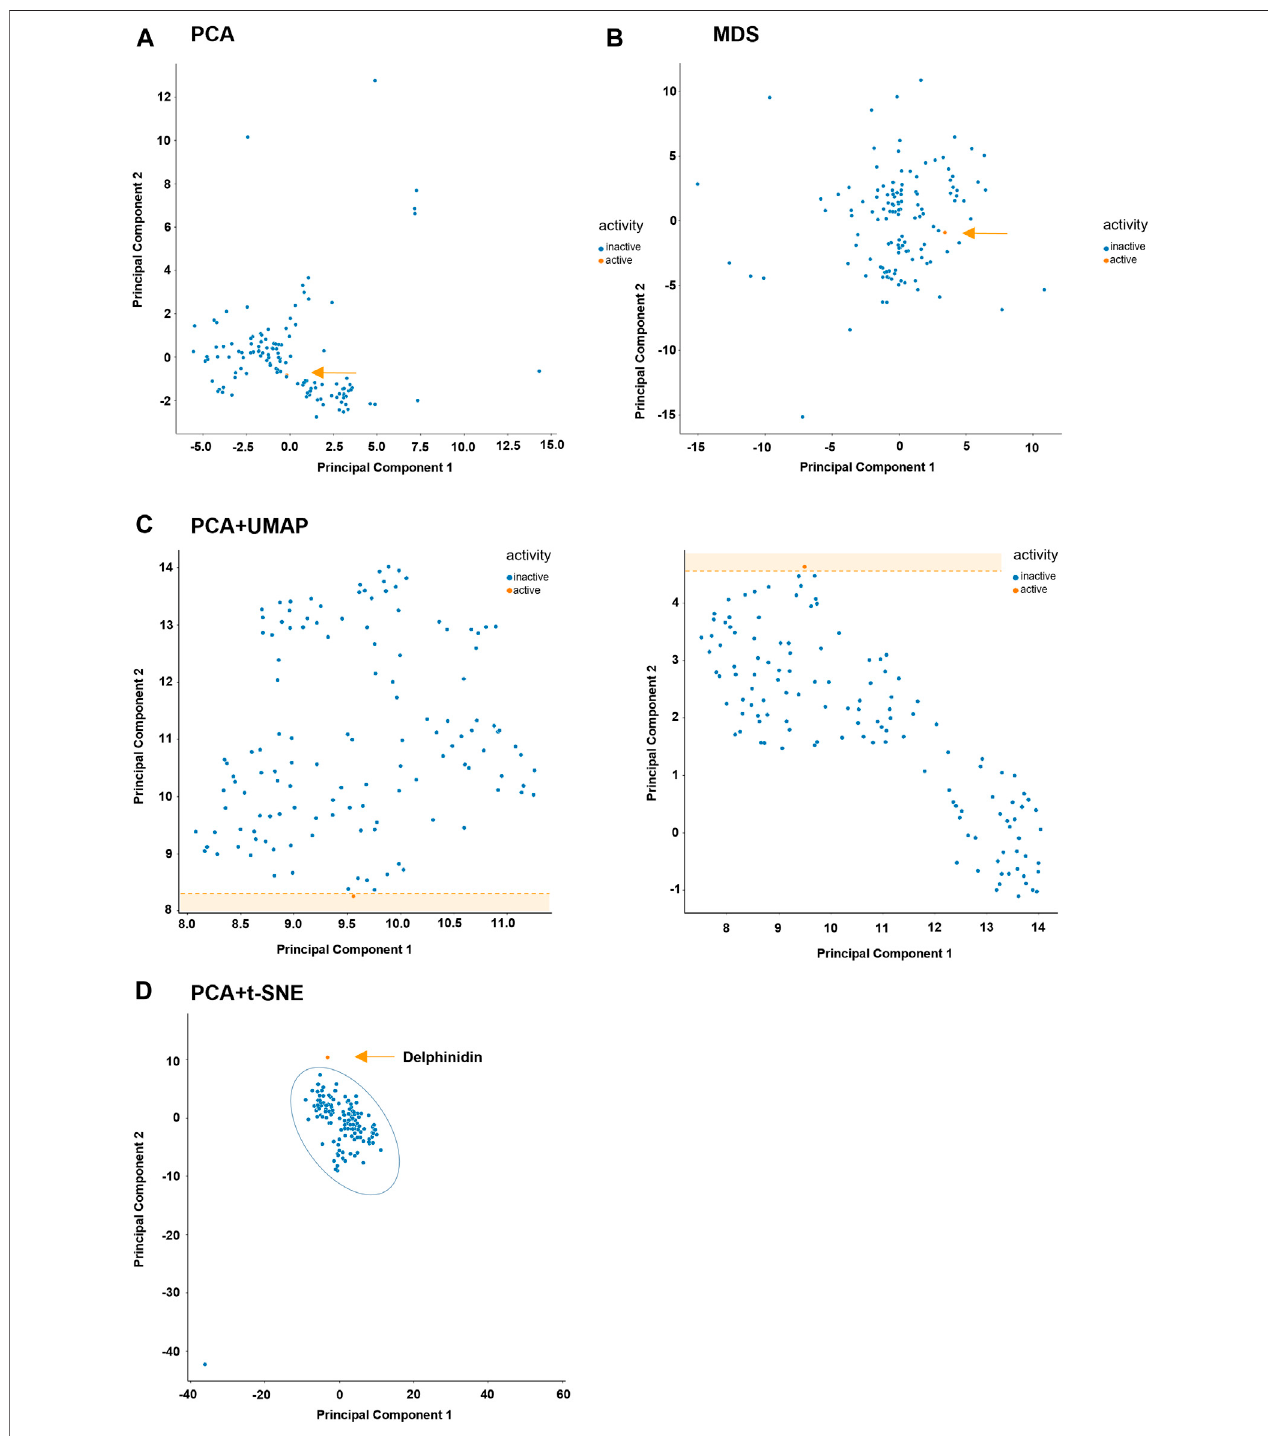
FIGURE8| Differentdimensionalityreduction methods applied tochemical libraryunder study.The activemoleculedelphinidinispresented inorangeand inactive molecules in blue. (A) variation explained: 0.9. (B) number of components: 2, metric MDS, max_iterations=300. (C: left) number of neighbors: 45; minimum distance: 0.01. (C: right) number of neighbors: 45; minimum distance: 0.1. (D) perplexity: 50; number of iterations: 300.